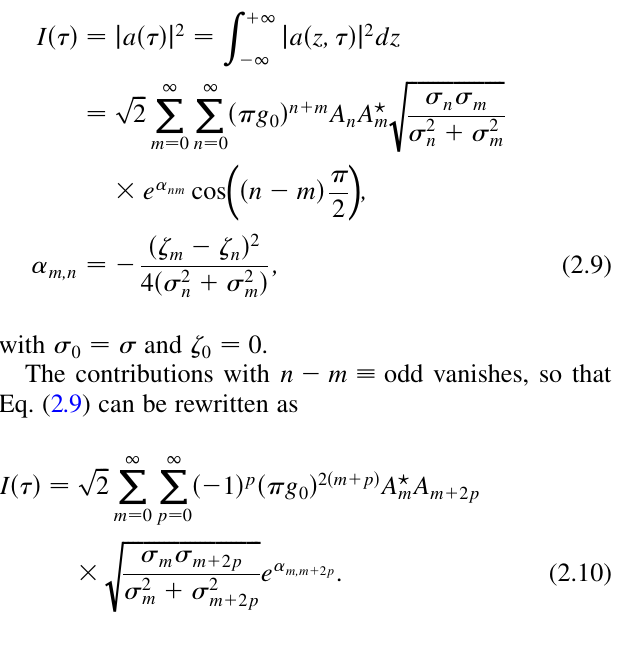
ffiffiffiffiffiffiffiffiffiffiffiffiffiffiffiffiffiffiffiffiffiffiffiffiffiffiffiffiffiffiffiffiffiffi p of the optical Fig. 2 and the rms (cid:3) ð (cid:1) Þ ¼ pulse is shown in Fig. 3. The moment (cid:2) z ð (cid:1) Þ of Eq. (2.13) is relative to a frame moving at the light velocity, its evolu- tion with respect to the e-bunch is obtained by adding the shift D ¼ (cid:1) (cid:1) [Fig. 2(a)]. The figures are relevant to the case of a short electron bunch and contain the com- parison with PROMETEO simulations. As to the centroid shift the comparison exhibits a qualitative agreement only [Figs. 2(a) and 2(c)]. To make analytical and numeri- cal results closer, we have replaced (cid:1) with 0 : 6(cid:1) thus ‘‘simulating’’ a slower drift velocity. Such a